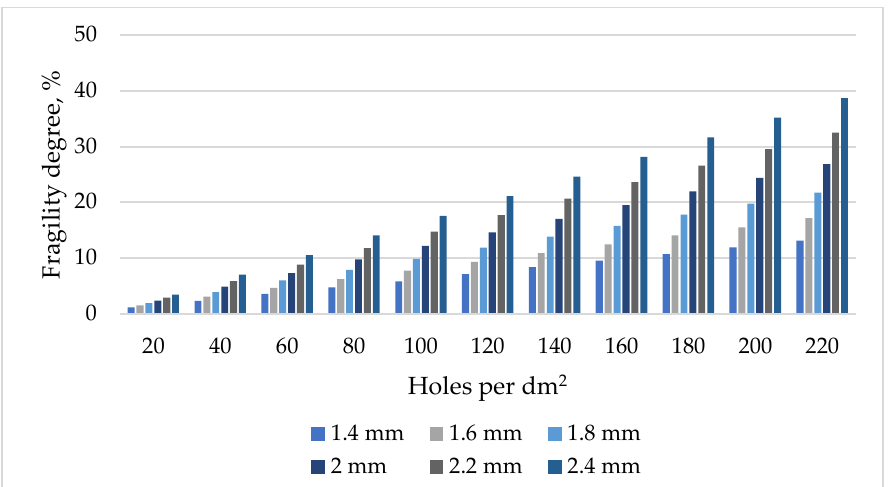
Figure 8. Fragility-degradation degree caused by xylophagous insects.